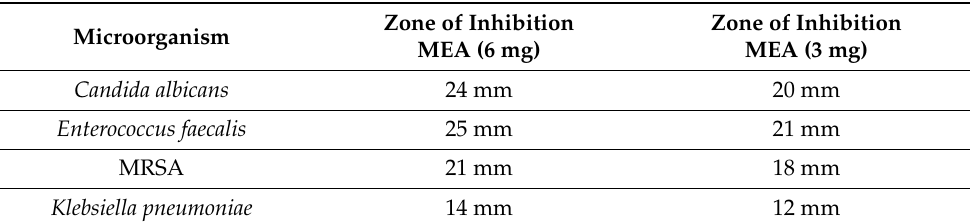
Table 1. Measurements of the zones of inhibition of the antimicrobial activity of AAE against C. albicans , E. faecalis , MRSA, and K. pneumoniae .